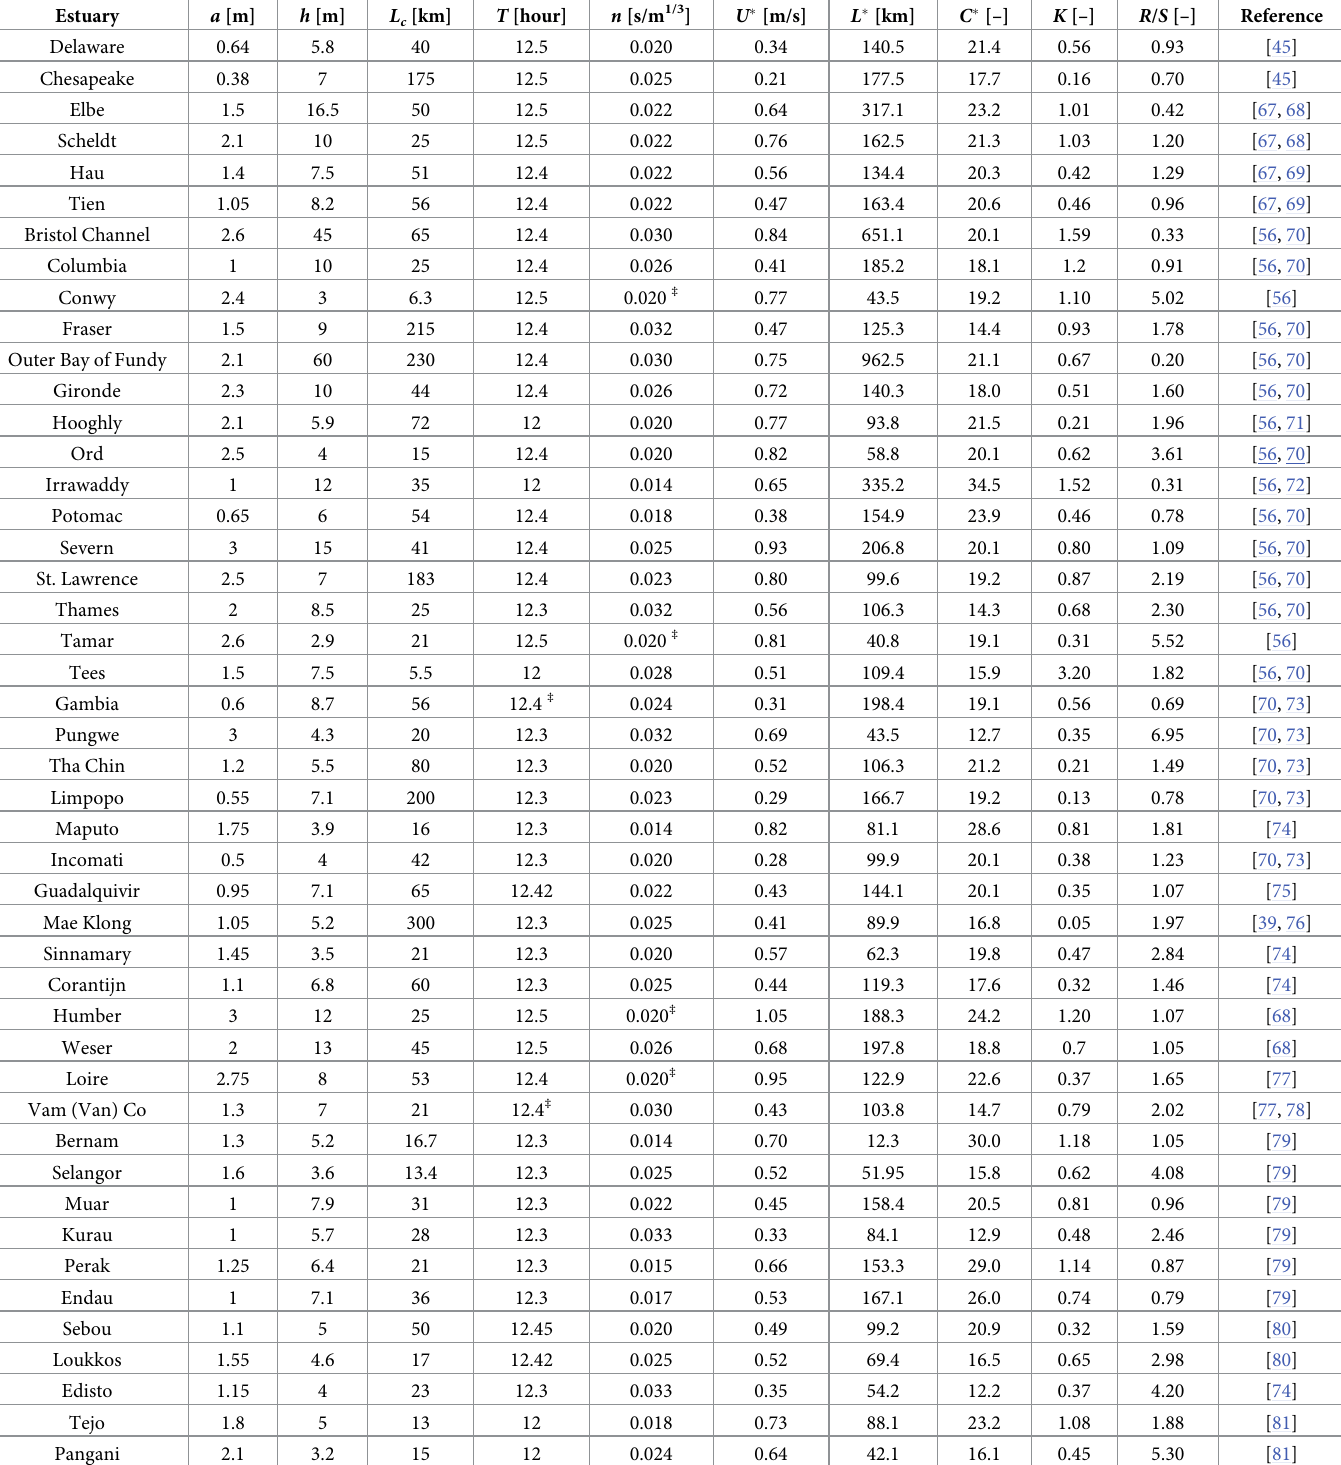
Table 2. Geometric and tidal properties of selected real-world estuaries extracted from existing analytical and semi-analytical studies along with measured dimen- sionless parameters defining estuarine classification. The values of a , h , L c , T , and n are taken from the corresponding references, and U � , L � , C � , K , and R / S are calcu- lated using Eqs